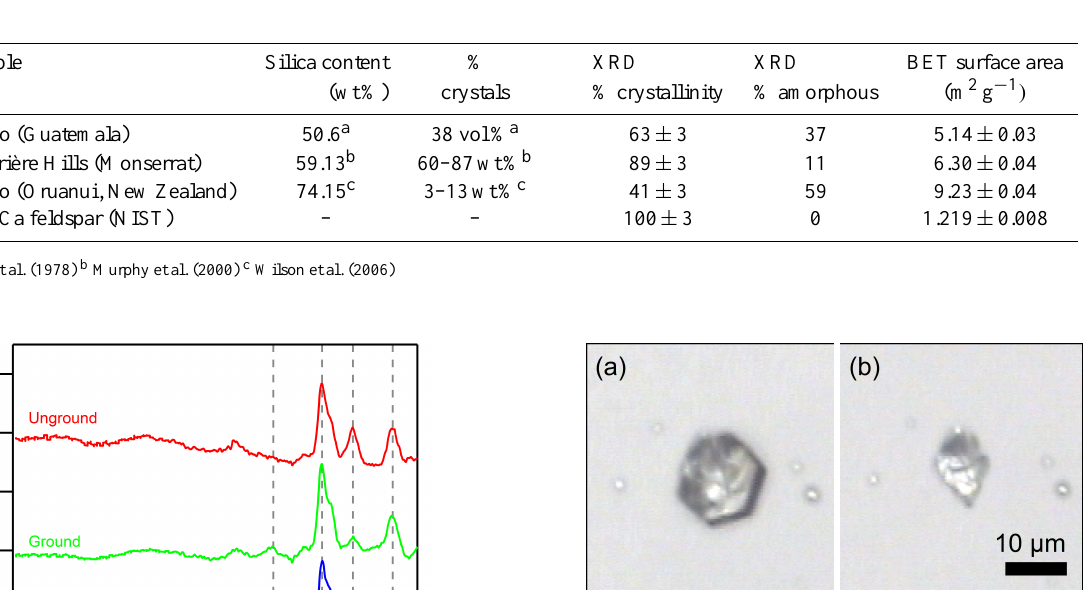
Table 1. Silica content, % crystals from previous whole-rock studies, XRD % crystallinity and % amorphous, and the BET surface areas of representative volcanic rock and ash samples from the Fuego, Soufrière Hills, and Taupo volcanoes and powdered NIST SRM-99b Na / Ca feldspar.